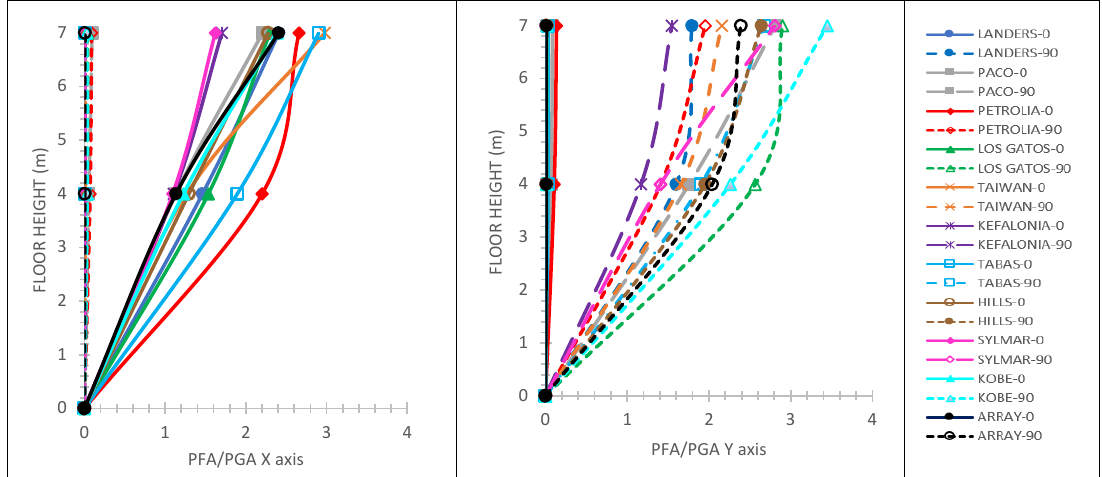
Figure 6. PFA/PGA along X ( left ) and Y ( right ) horizontal directions of the two-story mixed building, considering the fixed-pinned connection of the steel structure to the r/c one. Next, the three-story mixed building of Figure 1b is presented. The maximum IDR